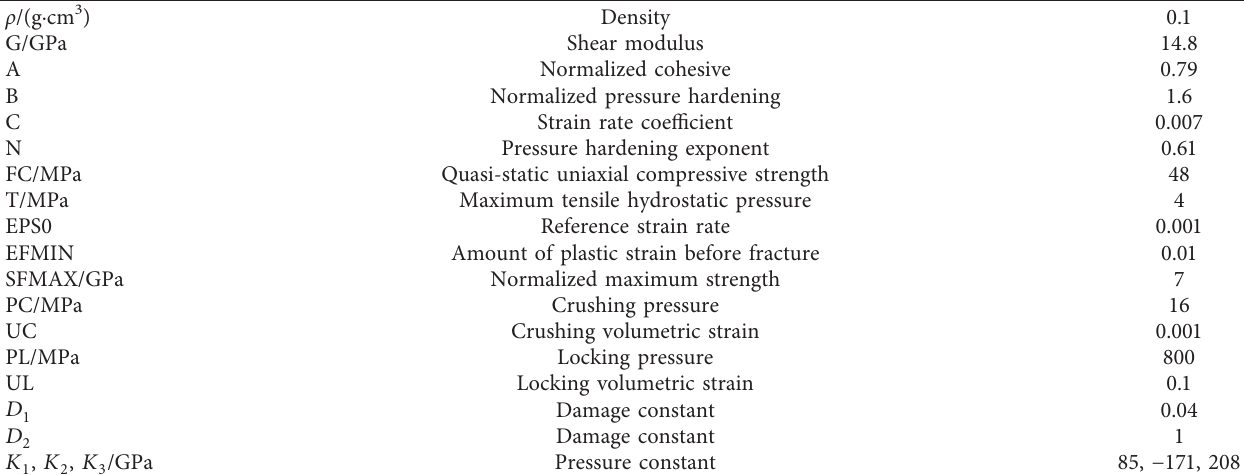
Table 3: Material parameters of the rock model.